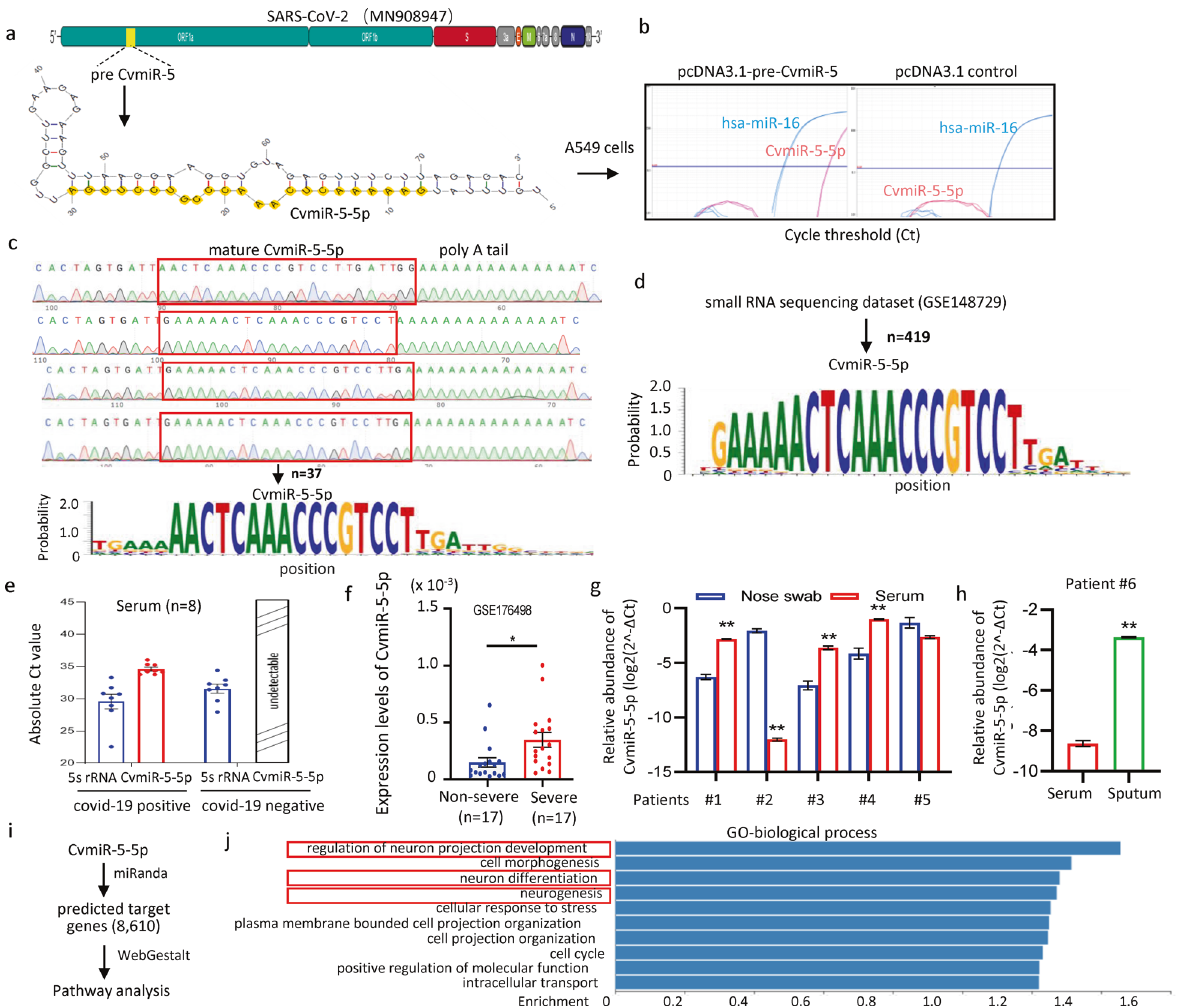
Fig. 1 Identi fi cation of a novel vmiRNA encoded by SARS-CoV-2 genome in covid-19 patients. a Sequence location and the secondary structure of pre-CvmiR-5. b QRT-PCR analysis of CvmiR-5-5p in A549 cells transfected with pre-CvmiR-5 or vector control. Hsa-miR-16-5p served as an internal control for small RNAs. The ampli fi cation curves were indicated. c Sequencing validation of the PCR products of CvmiR-5- 5p in b . The sanger sequencing graph was derived from 37 clones of CvmiR-5-5p ampli fi ed by PCR. d Sequence enrichment for CvmiR-5-5p motif derived from 419 reads in a small RNA sequencing dataset GSE148729 by analyzing the SARS-CoV-2 virus-infected Calu-3 cells. e Circulating CvmiR-5-5p analysis in eight serum samples from covid-19 patients (Patients #1 – 8) and eight serum samples from normal controls showing detectable in the patients with cycle threshold (Ct) values ~34 – 36, while undetectable in controls. 5s rRNA was used as an internal control of human small RNAs in circulation. f Comparison of the CvmiR-5-5p levels between non-severe patients and severe patients ( n = 17 in each group). Data were derived from a public dataset GSE176498. g CvmiR-5-5p analysis in serum and nasal swab samples from fi ve covid-19 patients (Patients #1 – 5) showing higher levels of CvmiR-5-5p in serums than nasal swabs in three of the fi ve patients, while opposite trend in one of the fi ve patients. h CvmiR-5-5p analysis in one pair sample of serum and sputum from covid-19 patient #6 showing a higher level of CvmiR-5-5p in the sputum than that in serum. i Schematic representation for target gene analysis of CvmiR-5-5p in human cells. j Pathways analysis by GO-biological process on the 8610 predicted potential target genes of CvmiR-5-5p indicating the main regulation of human nervous system including neurogenesis, neuron development, and neuron differentiation. All the analyses were performed in triplicates and repeated at least three times independently. Data were presented as the mean ± SEM. * p < 0.05; ** p <